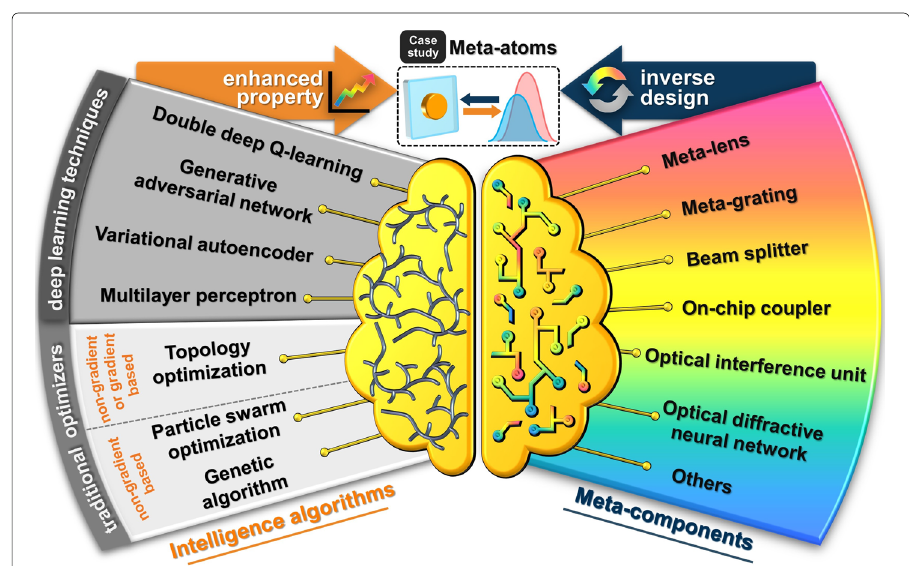
Fig. 1 A schematic categorization of intelligence algorithm-aided designs for nanophotonic components. The symbolic brain along with two arrows in the middle signifies that intelligence algorithms could boost optical properties and inversely develop on-demand photonic devices. In this review, the meta-atom spectral tuning (a dashed box) is given as a case study to illustrate two stages of intelligent methods. The splits extended from symbolic brain represent major substances explicitly outlined in the following context. The left gray backgrounds classify these algorithms as traditional optimizers (a light gray sector) and DL-based techniques (a dark gray sector), respectively, while the targeted functional meta-components are highlighted in the rainbow color-coded segment on the